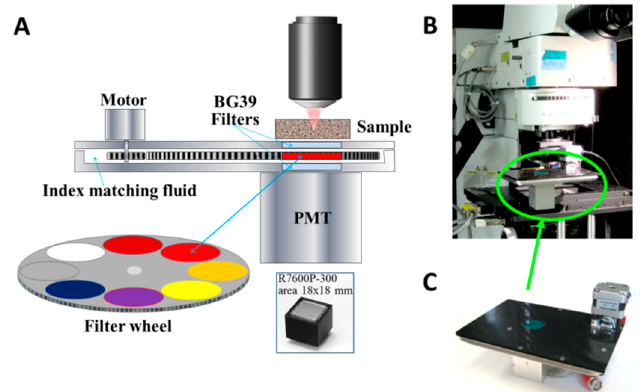
Figure 2. ( A ) The DIVER detector construction. ( B ) Picture of the commercial Olympus BX61 microscope with the DIVER detector. ( C ) Picture of the DIVER detector that can be plugged in the microscope